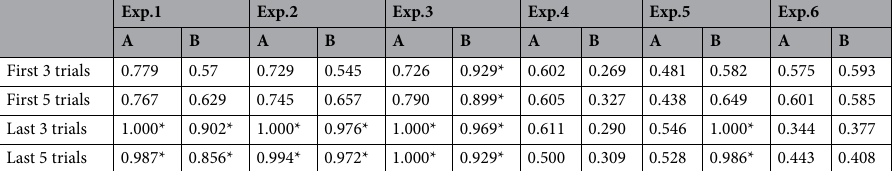
Table 1. Proportion of functional objects selected by all subjects in four stages. Proportion of functional objects selected by all subjects in the first third and fifth trials, and the last third and fifth trials. A) Azure- winged magpies, B) New Caledonian crows. Significant results are marked with * (P <